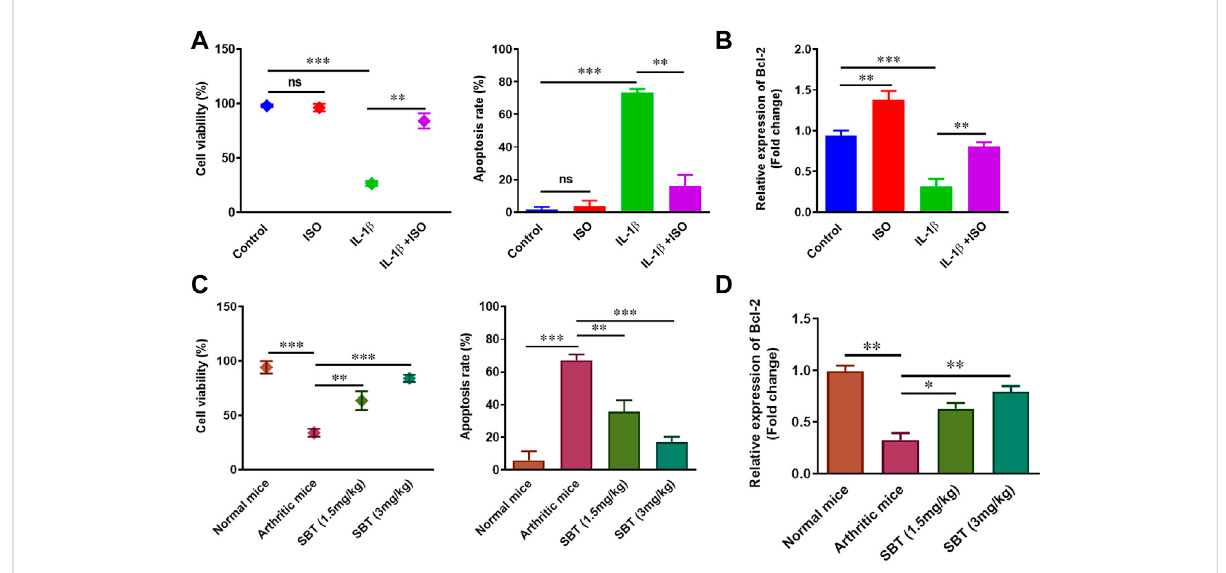
FIGURE 3 Cellsurvivalandapoptosisanalysis invitro and invivo .1×10 5 CHON-001cellswereseededincompleteDMEMculturemedium. (A) Cellviability and apoptosis of CHON-001 cells was assessed by Trypan blue exclusion method. (B) Relative Bcl-2 expression in CHON-001 cells measured by using qPCR. Results were analyzed by 2 – ΔΔ Ct method. (C) Cell viability and apoptosis rate of murine chondrocytes were assessed by Trypan